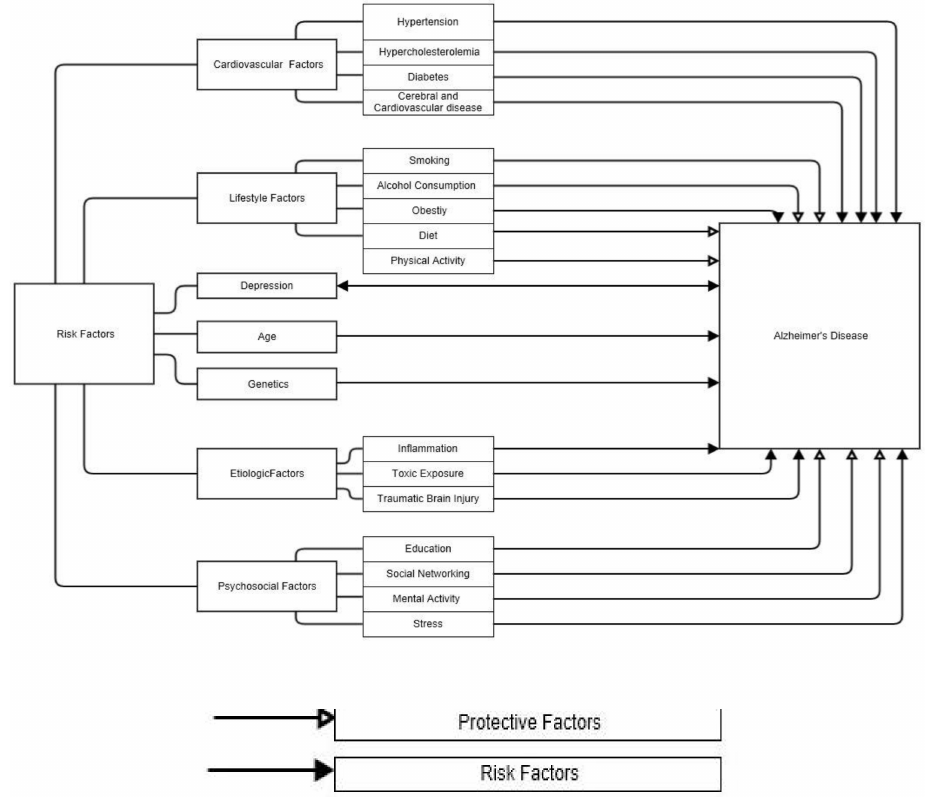
Figure 1. Protective and risk factors associated with Alzheimer’s disease